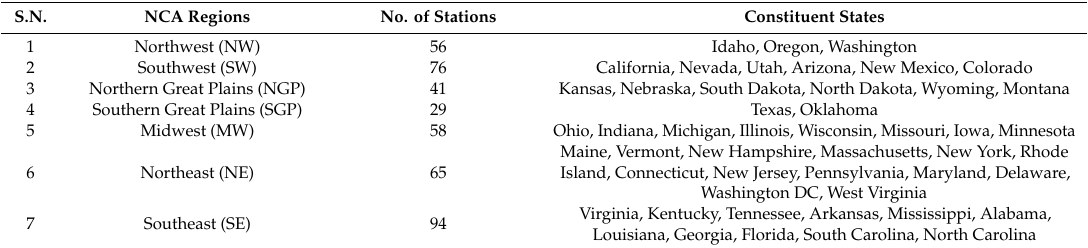
Table 1. National Climate Assessment (NCA) regions of the Contiguous US and their constituent states along with the selected number of streamflow stations within each NCA region.